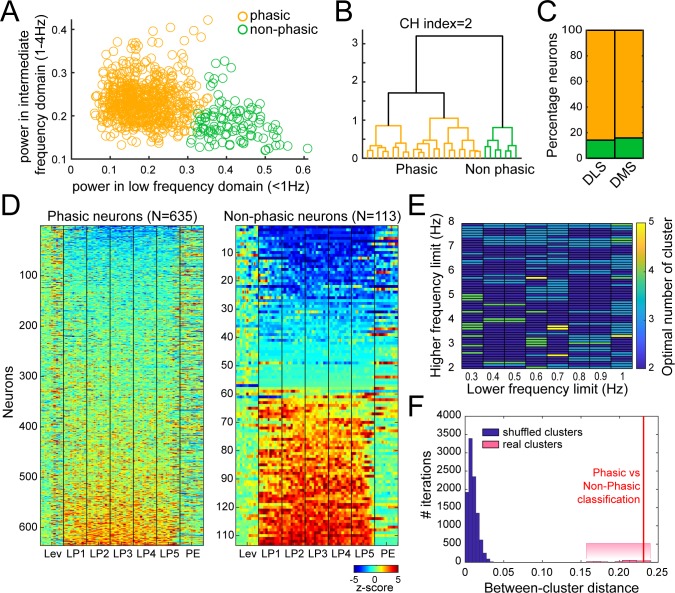
Fourier analysis and hierarchical clustering allowing separation of Phasic and Non-phasic neurons during extended training.Power in low (<1 Hz) and intermediate (1–4 Hz) frequency domains were used as features for hierarchical clustering. (A) Scatter plot of normalized power in low (<1 Hz) and intermediate (1–4 Hz) frequency ranges illustrating the separation of Phasic neurons (orange circles), and Non-phasic neurons (green circles). (B–C) Dendrogram (B) and proportion of Phasic and Non-phasic neurons in DMS and DLS (C). (D) Heatmaps of neural activity of Phasic (left) and Non-phasic neurons (right). (E) Generalization of classification results across ranges of low and intermediate frequency domains. The colormap indicates the optimal number of clusters as indicated by the Calinski-Harabasz criterion for each combination of parameters. The optimal number of clusters was 2 (60%) or 3 (33%) in 93% of parameters combination. (F) Permutation test for distinctiveness of the two clusters. Dark blue bars: Distribution of distances between cluster means of when neurons were randomly assigned to either the Phasic or Non-phasic clusters (10000 iterations; the clusters’ proportion were maintained as found by the hierarchical clustering approach). Red line: Actual distance between cluster means for the two clusters identified by our hierarchical clustering approach using power in low (<1 Hz) and intermediate (1–4 Hz) frequency domains as features. Pink bars: Distribution of actual distances between cluster means obtained by our hierarchical clustering approach across all combinations of frequency parameters in E that yielded two significant classes.